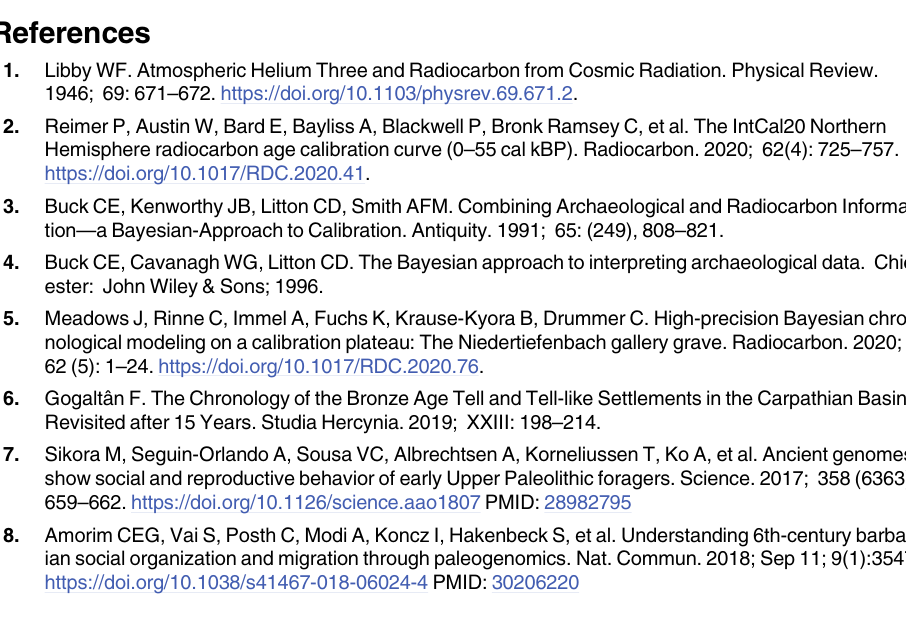
S13 Codes. OxCal codes for the Bayesian modelling of the entire pedigree of AITI with changed chronological order. The individuals are assigned to sequence levels based on the results of the pairwise comparisons (cf. Fig 23) and modelled without HBCO or intervals. The code is labeled according to the sheets in S8 Table